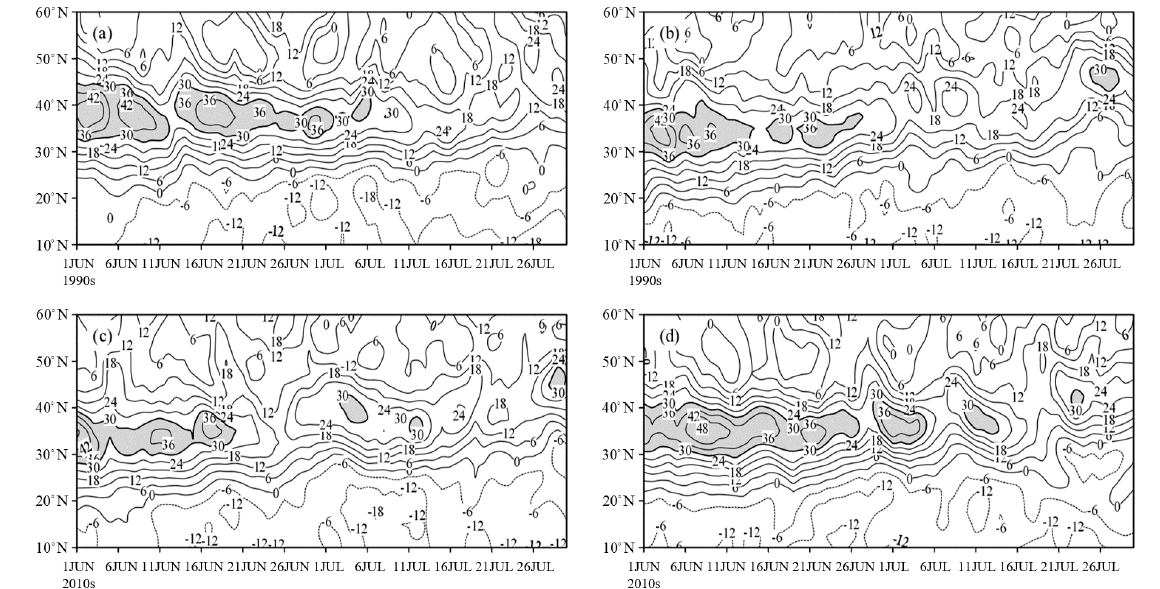
Figure 4. Time-latitude profile along the mean 110~130 ° E of 200-hPa mean zonal wind from June to July (the solid line denotes wind speed, unit: m · s − 1 ; the shaded areas denotes wind speed exceeding 30 m · s − 1 ) of years of early Meiyu arrival in the 1990s ( a ), late Meiyu arrival in the 1990s ( b ), early Meiyu arrival in the 2010s ( c ), and late Meiyu arrival in the 2010s ( d ).